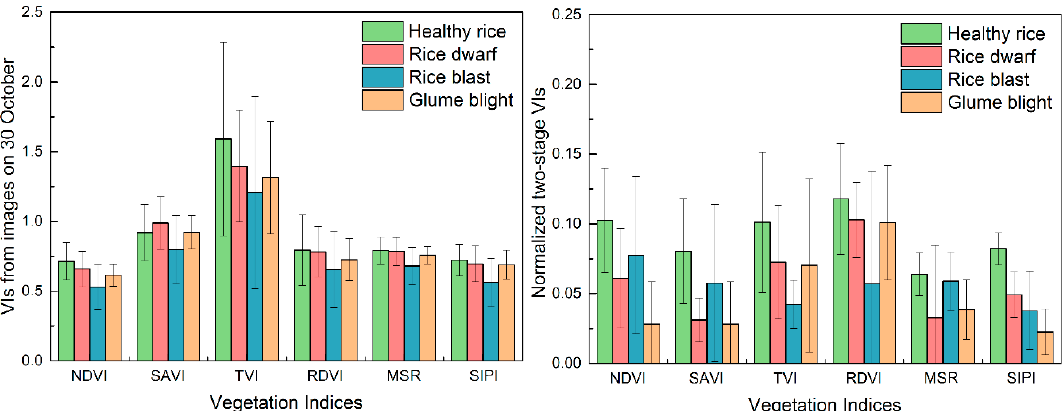
Figure 3. The mean and standard deviations of pixel-based single-date VIs shown on ( left ) and normalized two-stage VIs shown on ( right ).